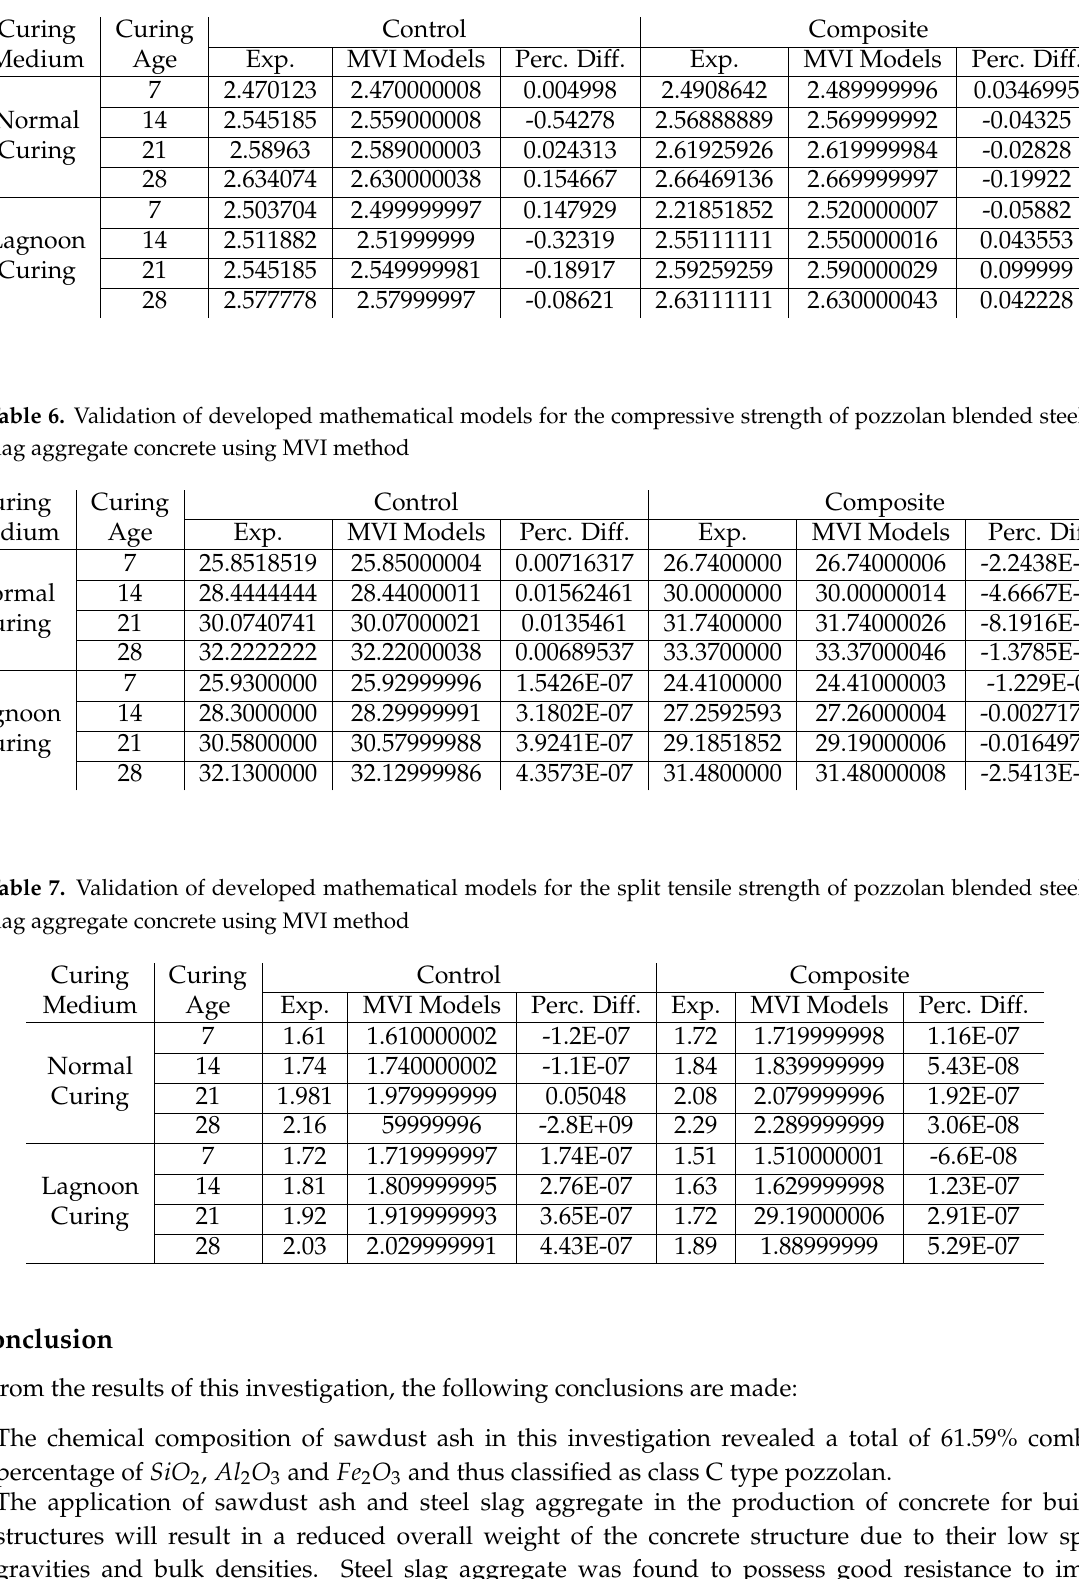
Table 5. Validation of developed mathematical models for the density of pozzolan blended steel slag aggregate concrete using MVI method